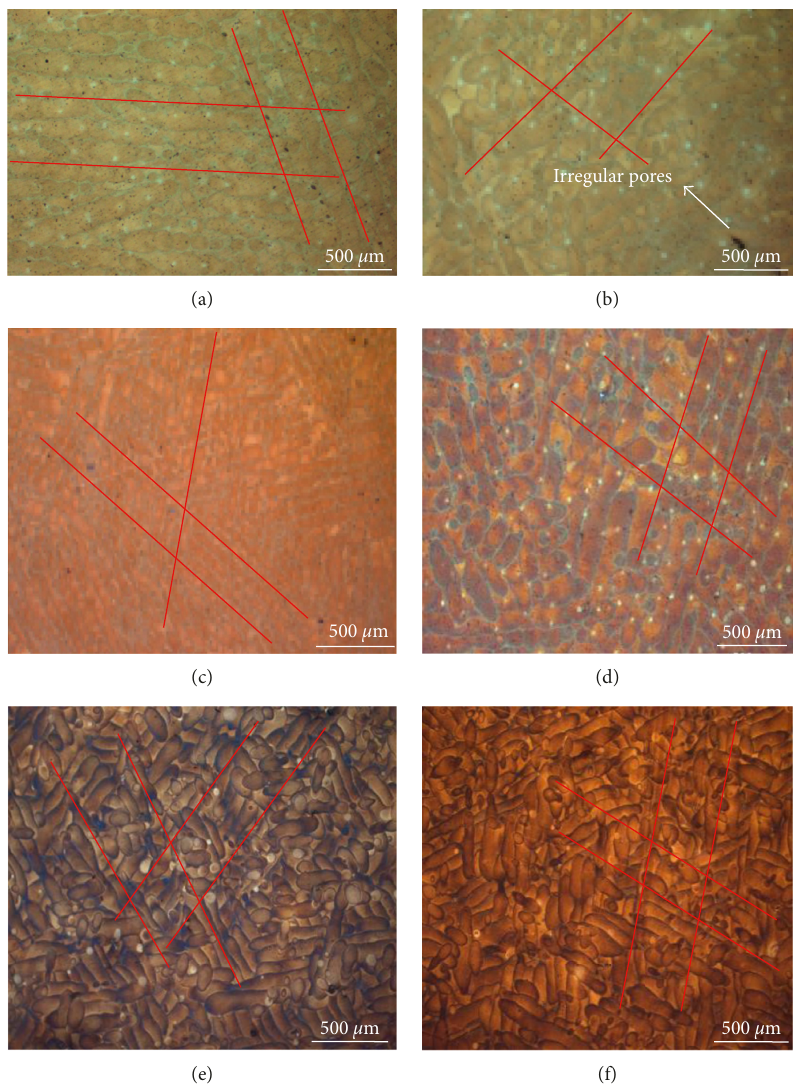
Figure 10: The typical etched morphology of vertical section surface of SLM-processed AlSi10Mg samples at (a) chessboard scanning, preheating temperature of 80 ° C; (b) chessboard scanning, preheating temperature of 120 ° C; (c) chessboard scanning, preheating tem- perature of 160 ° C; (d) uniformity scanning, preheating temperature of 80 ° C; (e) uniformity scanning, preheating temperature of 120 ° C; and (f) uniformity scanning, preheating temperature of 160 °